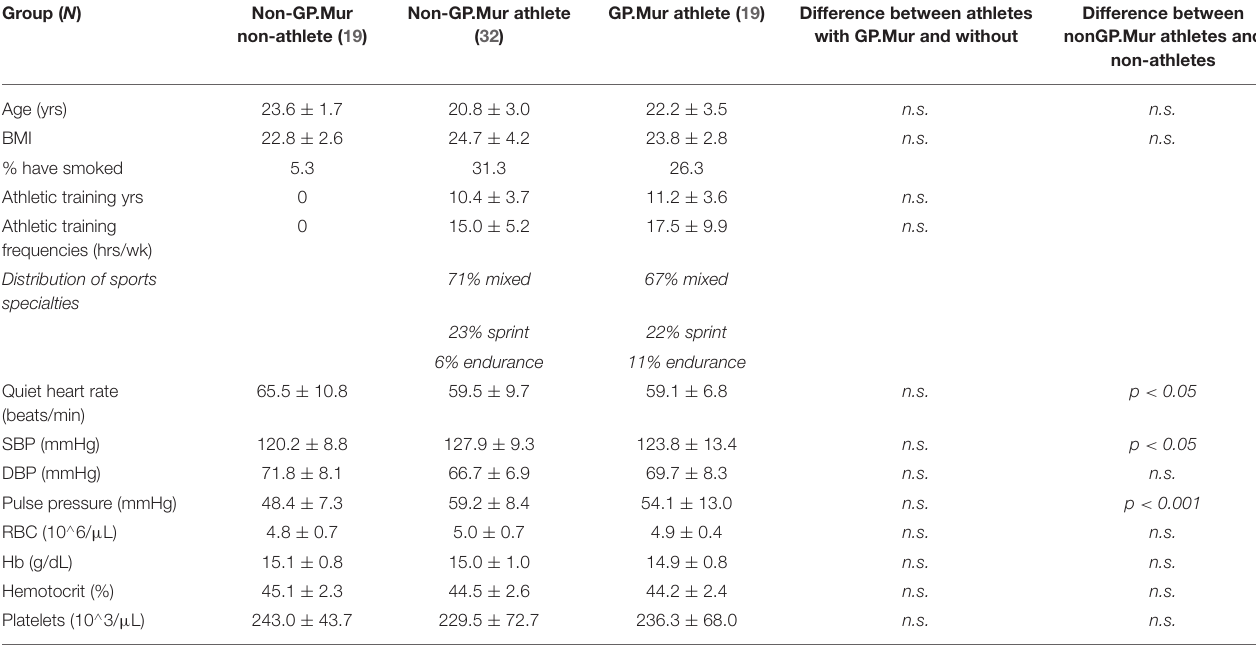
TABLE 1 | Subject characteristics. Group ( N ) Non-GP.Mur